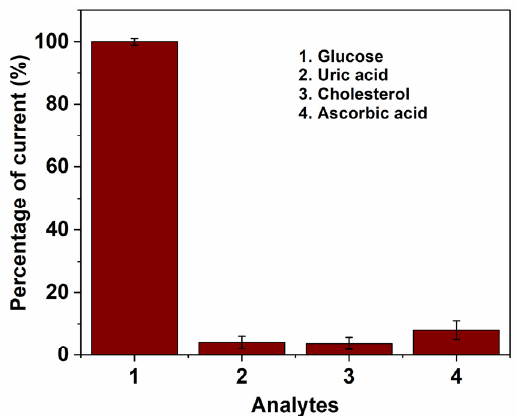
Figure 5. Influence of common electroactive interferences with (1) glucose (2 mM), (2) Uric acid (5 mM), (3) Cholesterol (5 mM) and (4) Ascorbic acid (5 mM) measured with 3D/RGO-PEI/GOx pyrolytic carbon electrodes. Working potential = 0.15 V, (n = 3).